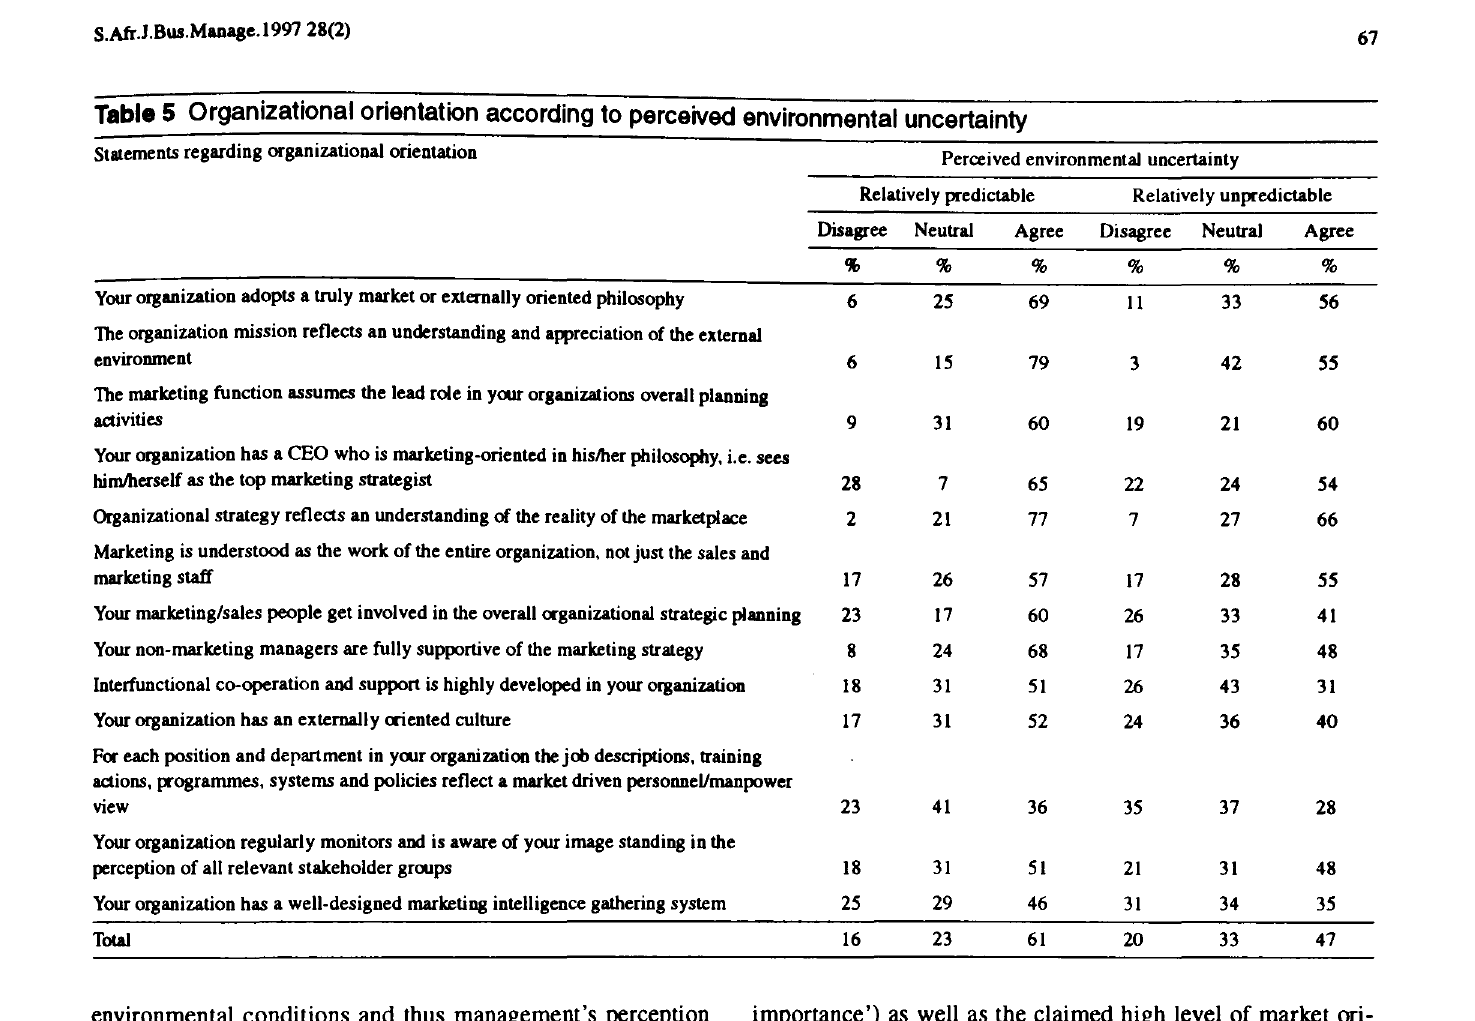
Table 5 Organizational orientation according to perceived environmental uncertainty Statements regarding organizational